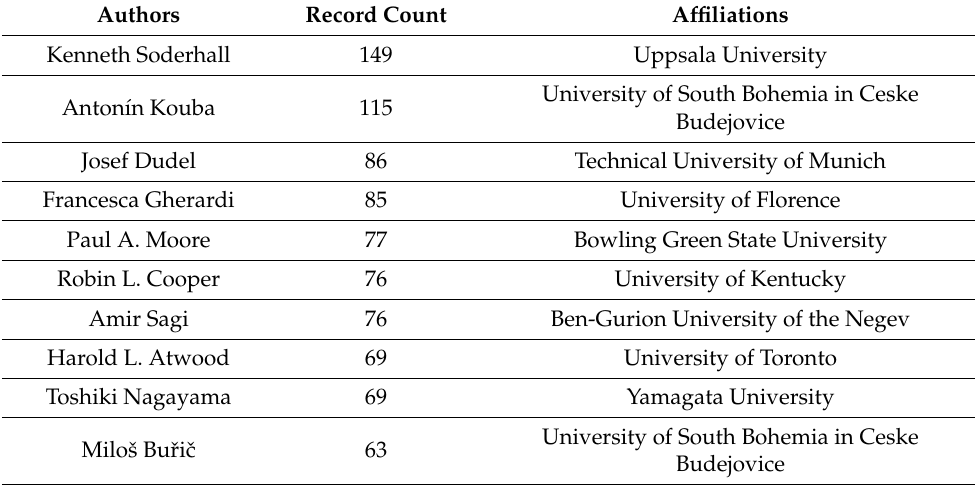
Table 1. Top 10 authors involved in crayfish research worldwide.